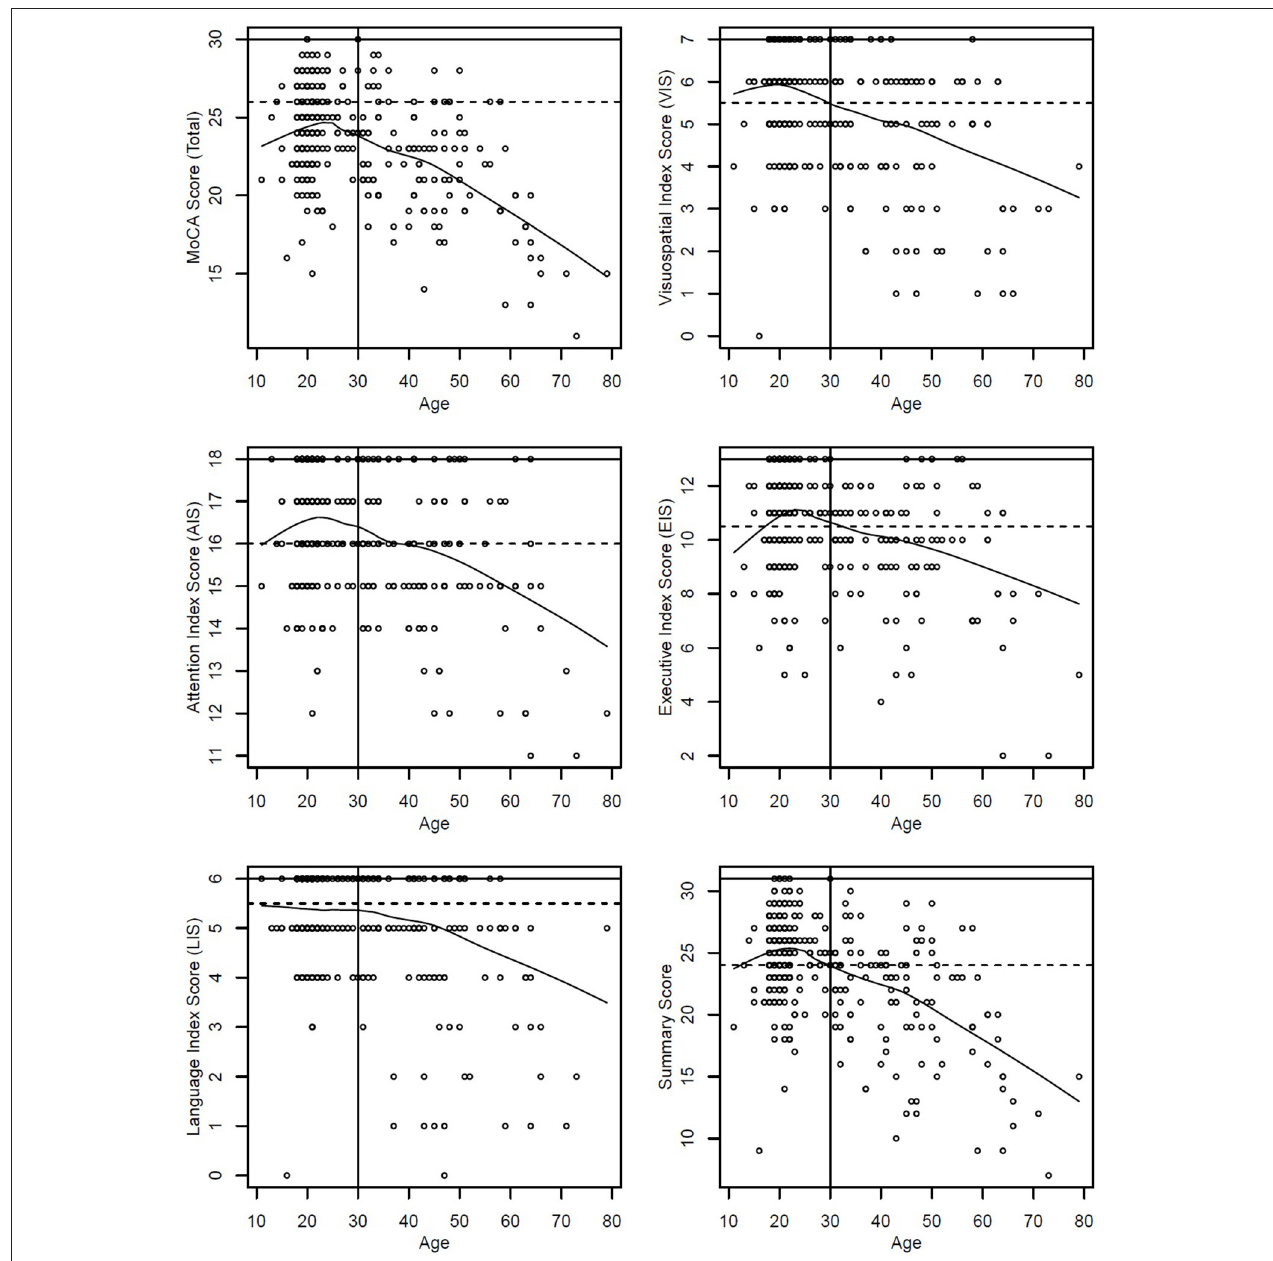
FIGURE 2 | The cognitive decline for the entire group is shown for MoCA total score, and for each Cognitive Index Scores (solid line maximum score and dashed line cutoff